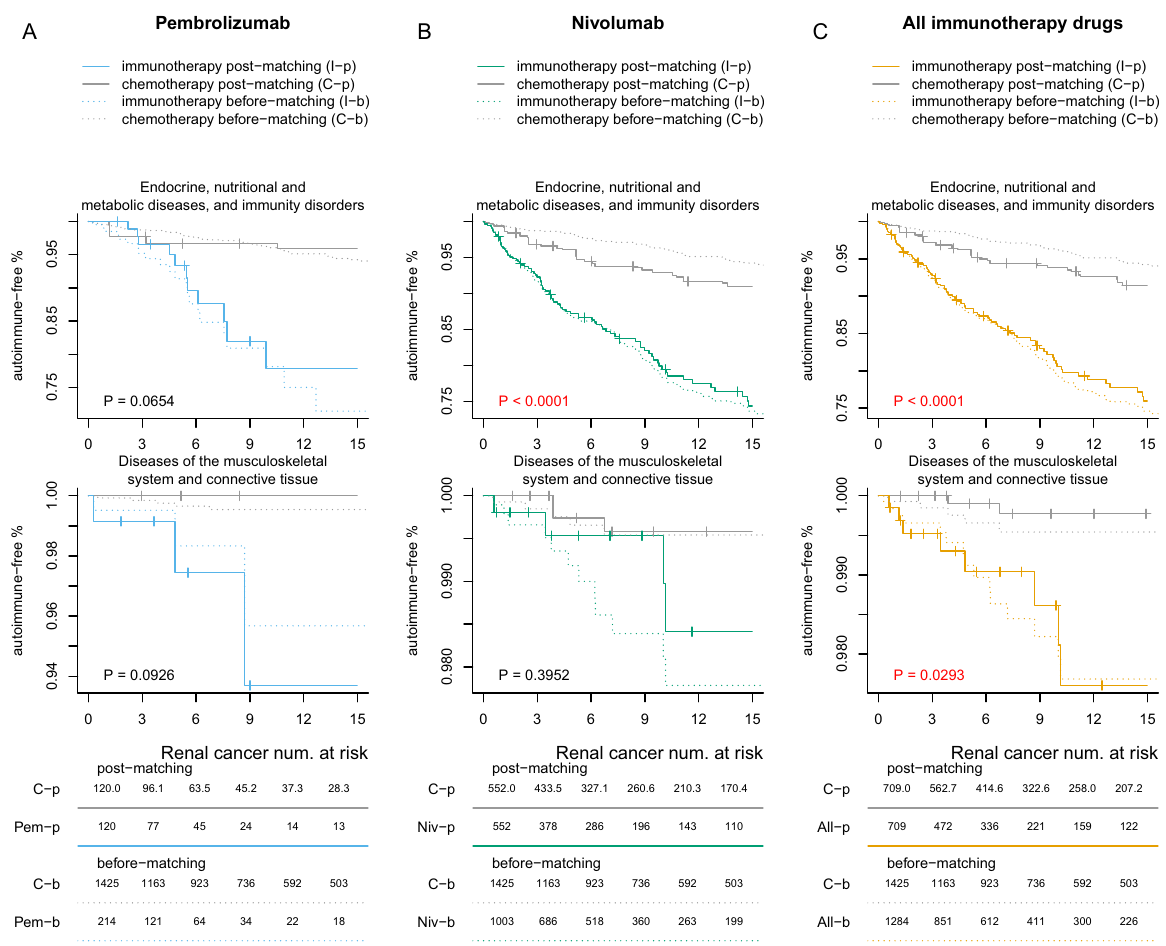
Fig. 5 Time-to-event plot showing the time between treatment initiation and the development of irAE groups 32 . A Pembrolizumab. B Nivolumab. C All immune checkpoint